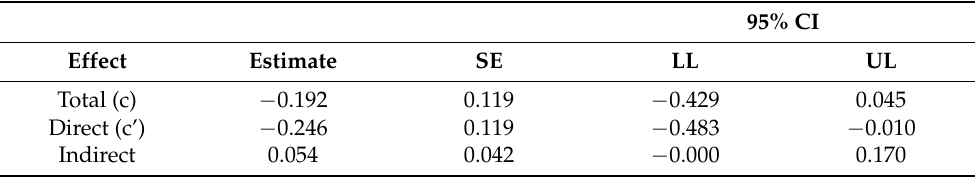
Table 2. The Total, Direct, and Indirect Effect of BZSG in the Relation between Workload and Reducing Hindering Job Demands. 95% CI Effect Estimate SE LL UL Total (c) − 0.192 0.119 − 0.429 0.045 Direct (c’) − 0.246 0.119 − 0.483 − 0.010 Indirect 0.054 0.042 − 0.000